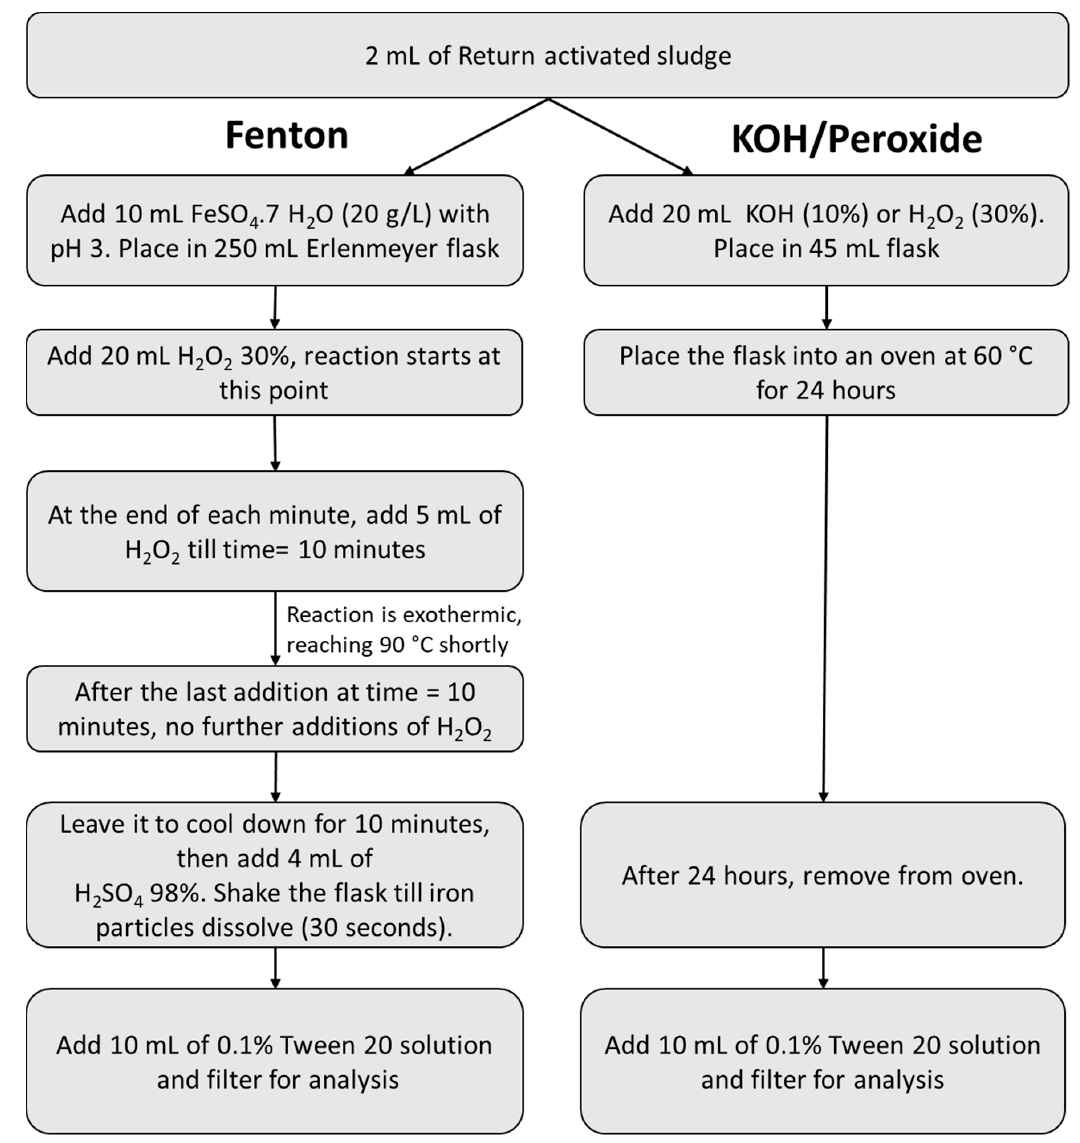
Figure 1. Workflows of the three selected protocols for processing microplastics from wastewater sludge